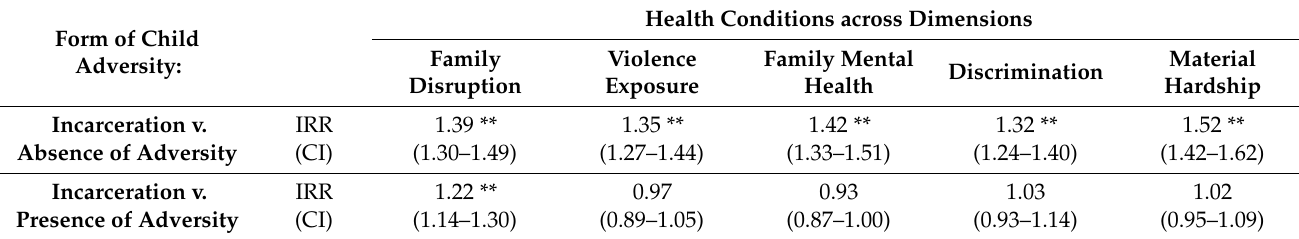
Table A1. Parental Incarceration and Child Health ACROSS Dimensions: Strategic Comparison Approach by Adversity Subcategory. Form of Child Adversity: Incarceration